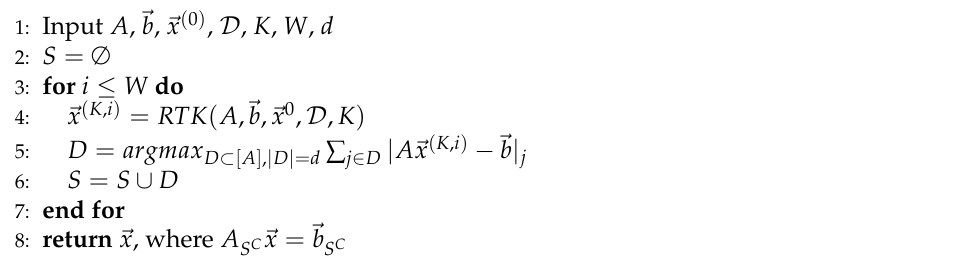
Algorithm 2 Multiple Round Randomized Tree Kaczmarz (MRRTK)